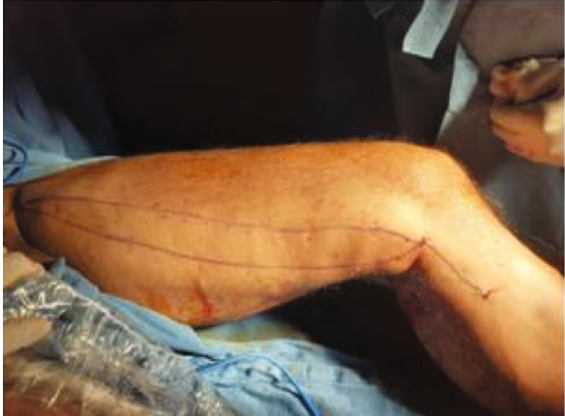
Figure 3: Marking of double GSV.